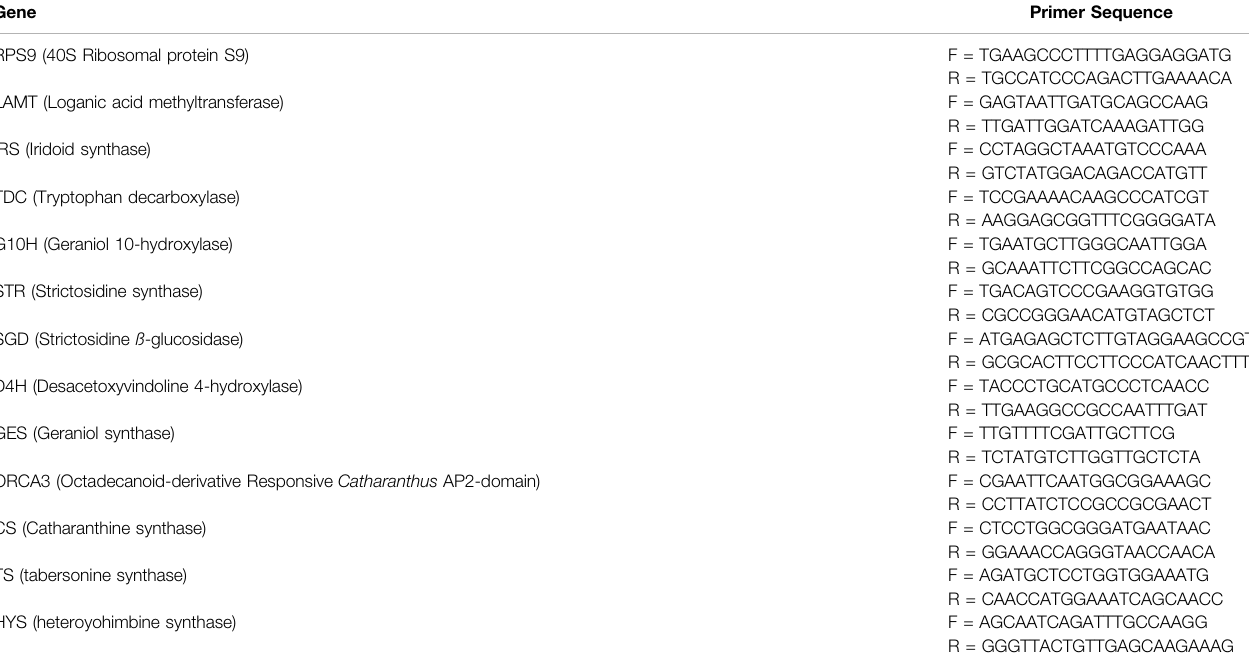
TABLE 1 | Primers for qRT-PCR analyses of C. roseus reference and TIA biosynthetic genes.